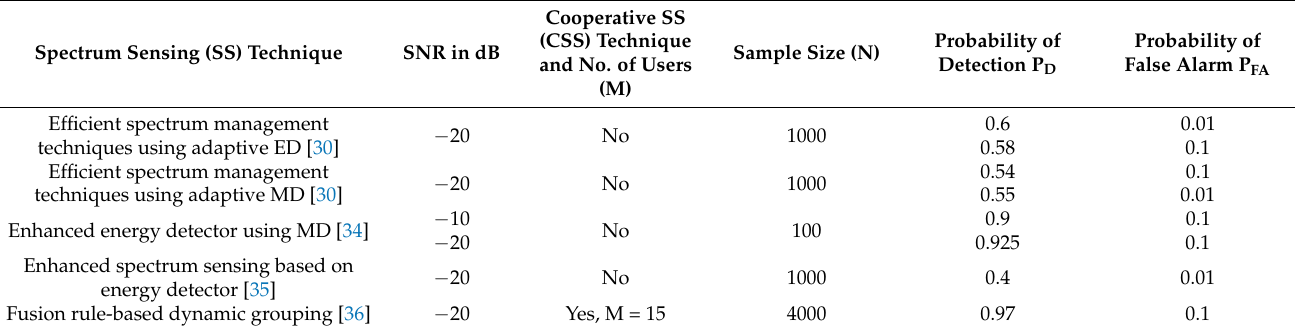
Table 1. Comparison of existing SS techniques based on parameters required for IEEE 802.22 WRAN